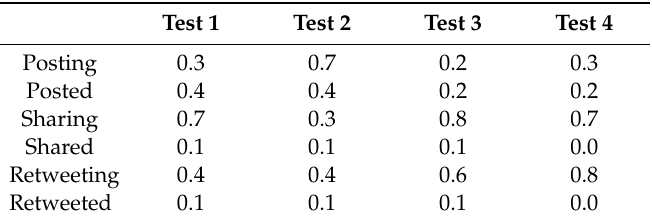
Table 3. Four sets of edge weights for di ff erent user actions.